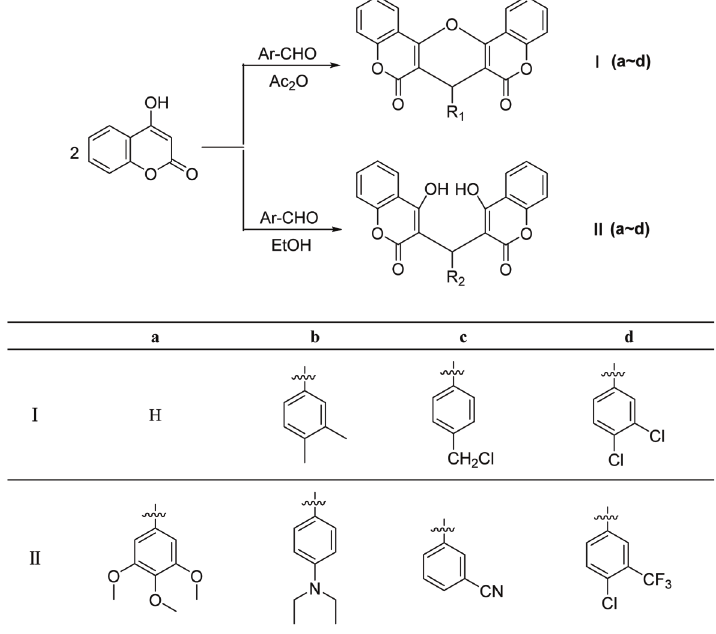
Figure 1. Synthesis route of compounds I (a – d) and II (a –